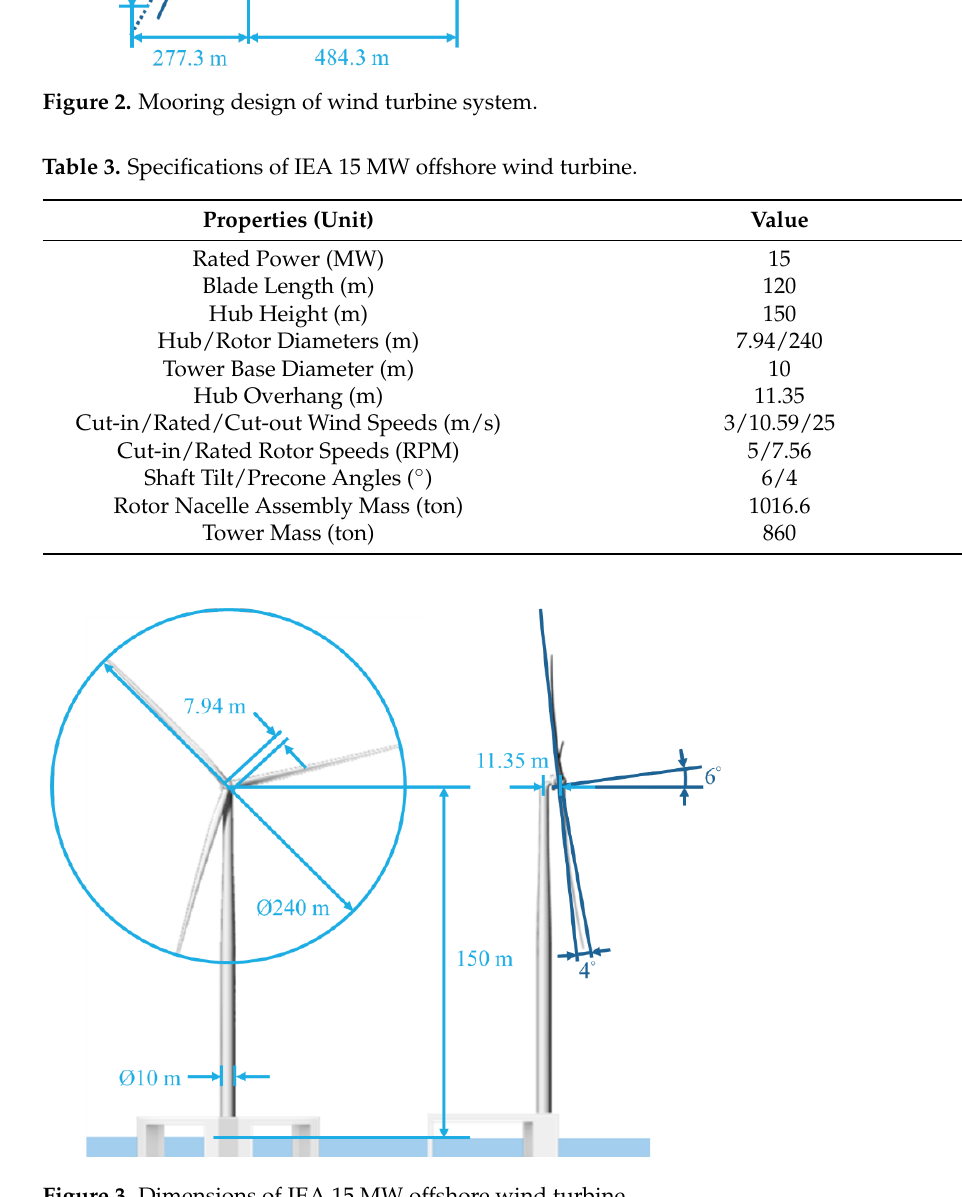
( d ) Figure 4. Comparison of ( a ) blade pitch angle, ( b ) generator power, ( c ) rotor speed, and ( d ) rotor thrust force between this study and [18]. 3. Numerical Methods A numerical framework for predicting the motion response and power performance of a floating wind turbine system is proposed in this study (Figure 5), in which the metocean condition of the Hsinchu offshore area is referenced from [35,39]. The hydrody- namic properties were predicted using ANSYS-AQWA via the potential-flow approach. The forced motion of the platform was simulated using STAR-CCM+ to obtain the hydro- dynamic properties considering the viscous effects. The aerodynamics and dynamics of the mooring system were calculated using OrcaFlex via the blade element momentum theory and finite element method. With all these results, the equations of the motions were solved, and the motion response and generator power of the wind turbine system were obtained. Figure 5 shows the numerical framework for predicting the motion response and power performance of a floating wind turbine system. The numerical details of ANSYS-